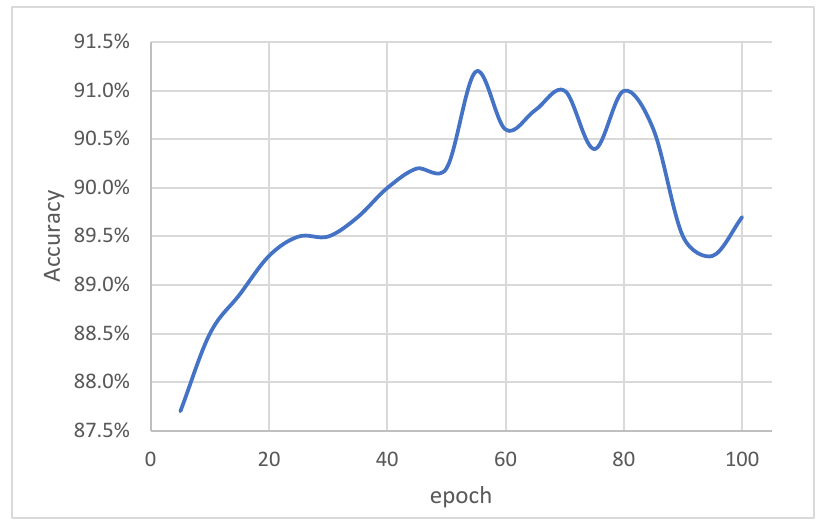
Figure 4. The accuracy of the multimodal model in the second step of Task 2.